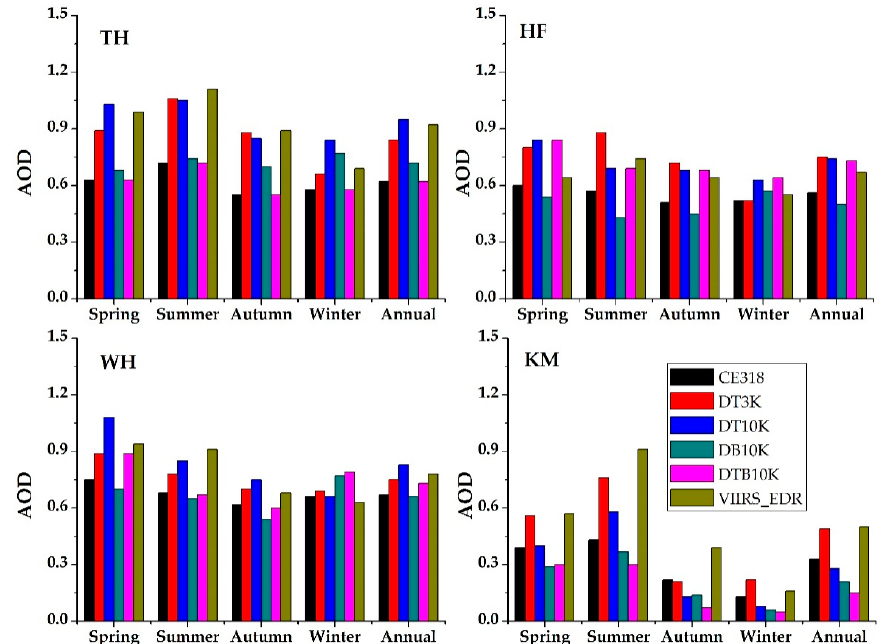
Figure 8. Seasonal and annual variation of the Aqua-MODIS C6 and VIIRS_EDR AOD retrievals (QF = 3) and CE318 AOD observations, respectively at TH, HF, WH and KM for the period of 2 May 2012– 31 December 2016.